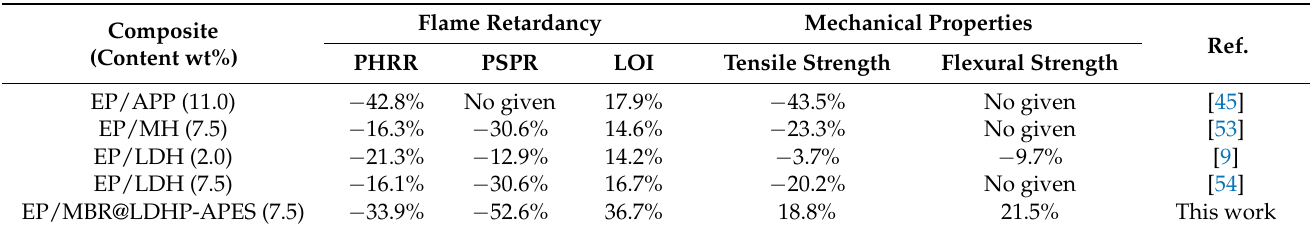
Figure 9. LOI of pure EP and its composites. Table 5. Combustion and mechanical properties of previously reported EP composites.